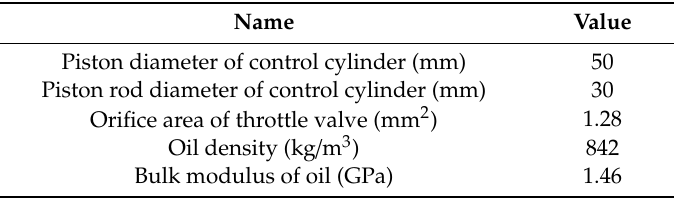
Table 1. Basic simulation parameters of anti-kink system.